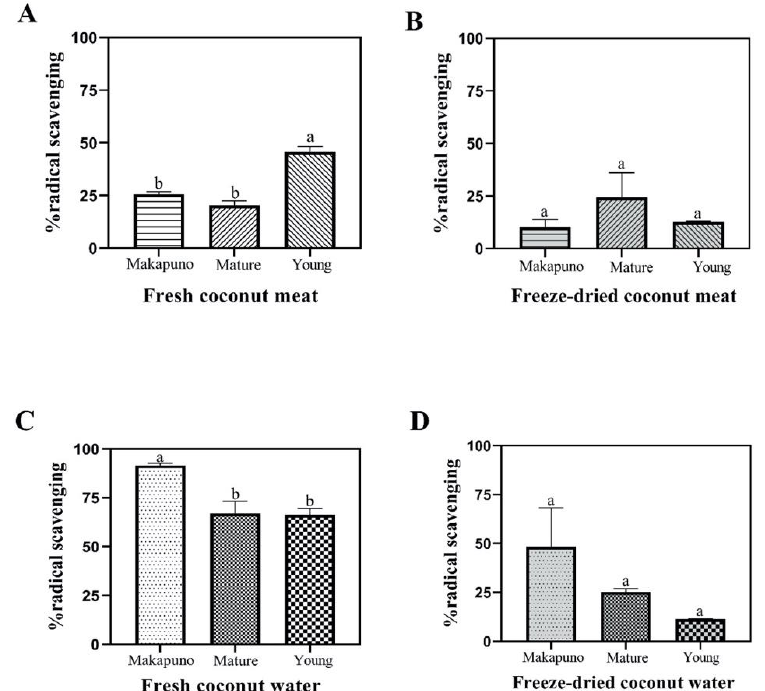
Figure 8. ABTS assay. ABTS assay of coconut meats in fresh ( A ) and freeze-dried ( B ) samples. ABTS assay of coconut water and Makapuno water in fresh ( C ) and freeze-dried ( D ) samples. All experiments were performed in triplicate. Data are expressed as mean ± SE (n = 3, p < 0.05) for all tested. Different letters indicate mean values significantly Natural resources are considered rich sources of antioxidants, which can help pre- vent the DNA damage caused by free radicals. Previous study reported that a DNA du- plex might form upon the binding of flavonoids with DNA, which could protect DNA from oxidative damage [54]. To further relate the antioxidant activity with the protection effect of coconut samples on the damaged biomolecules, Figure 9 shows the presence of the intact DNA band in agarose gel electrophoresis representing the protected DNA (Lane 2). We damaged DNA plasmid with the radicals generated from the Fenton reaction, as shown in Lane 3. Using this assay, we found that coconut samples exhibited DNA damage protection activity with different degrees. Methanolic extract of young coconut meat showed the highest degree of protection, as indicated by a bright DNA band, while the extract from Makapuno meat showed the least protection. Interestingly, similar protective effects were observed in water samples. These results are in agreement with the antioxi- dant activity observed in all samples studied. Altogether, this work showed that the co- conuts, regardless of age difference, exhibit antioxidant activities with different degrees of activity.